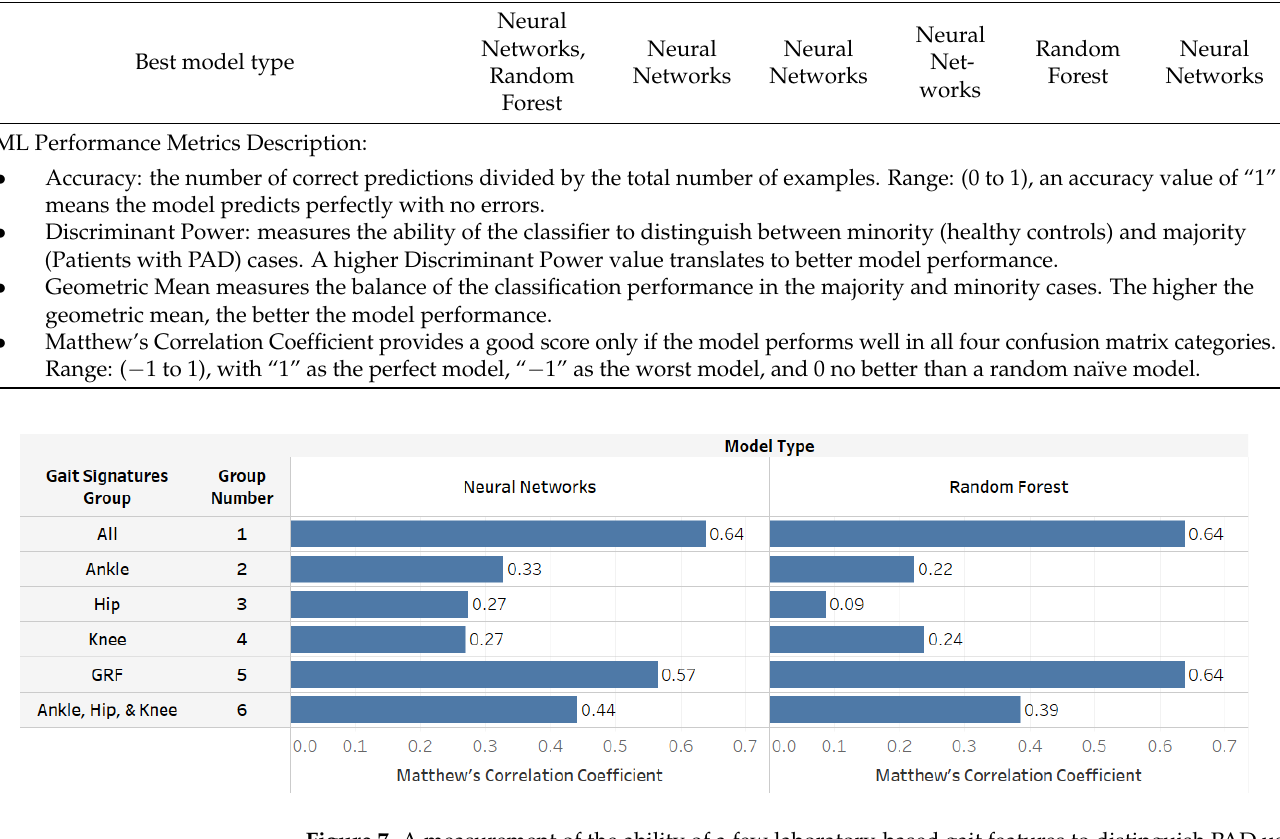
Figure 6. Performance metric results that measure the ability of each ML model algorithm to distin- guish PAD.